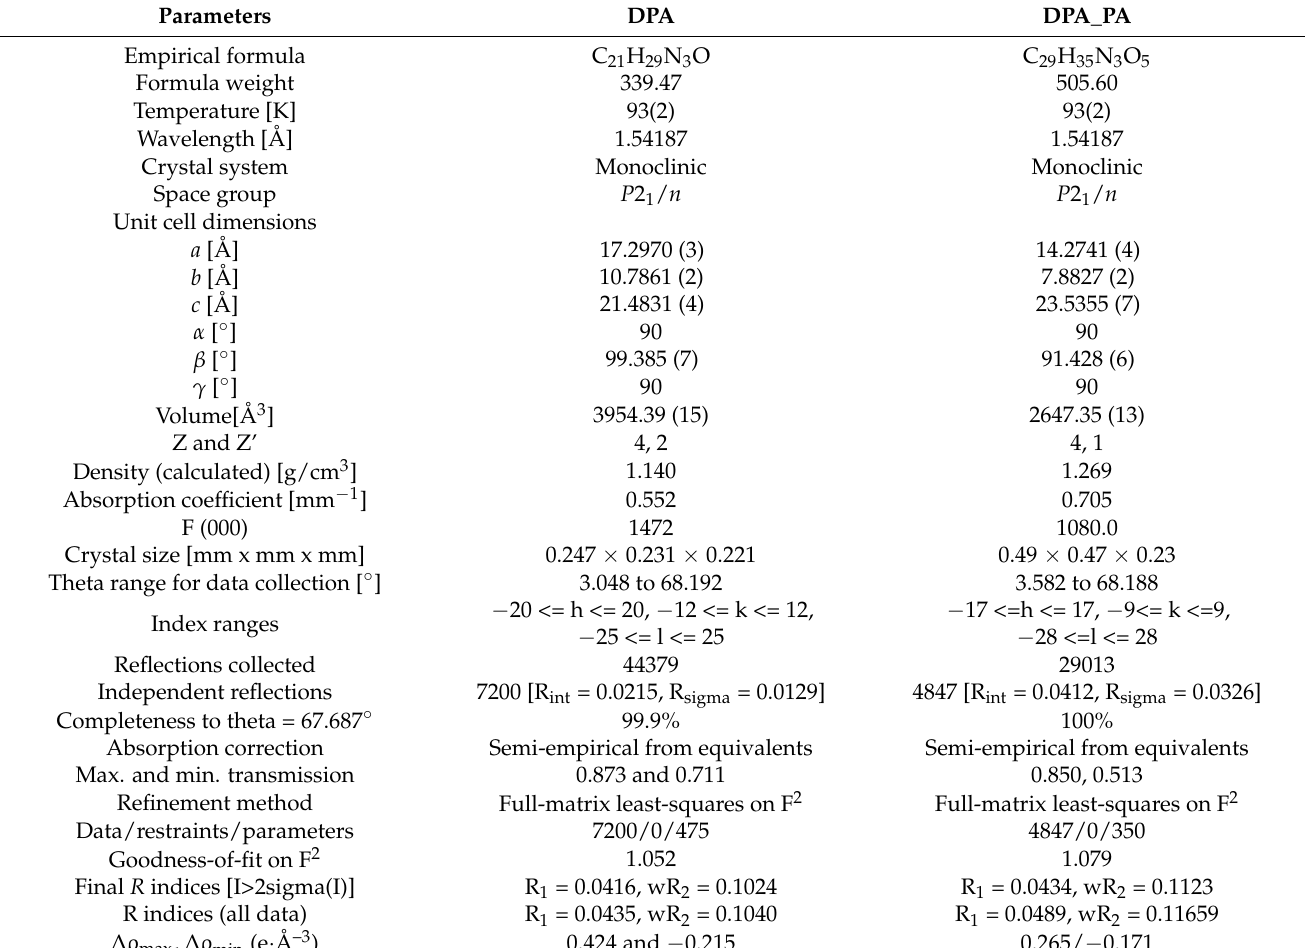
Table 1. Crystallographic data table for the DPA and DPA_PA salt.